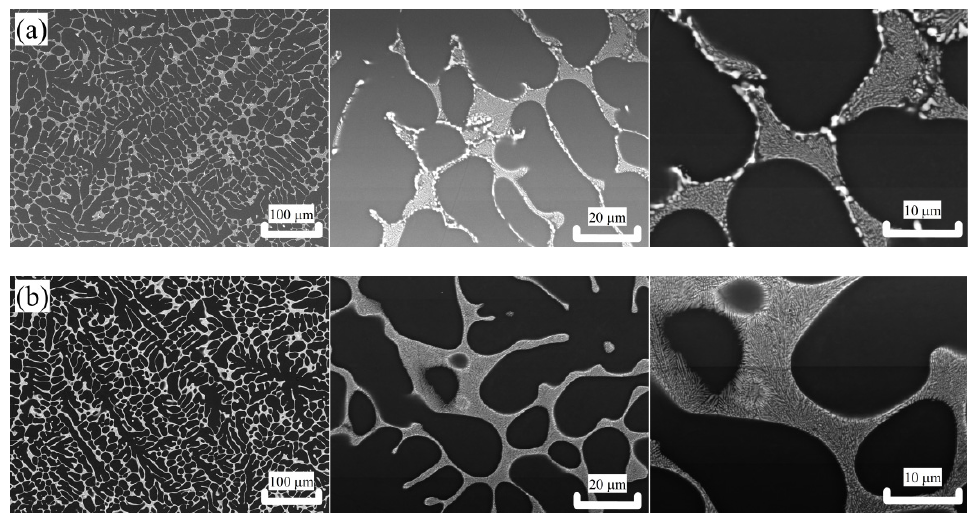
Figure 2. As cast microstructure of the Al-Cu-Yb ( a ) and Al-Cu-Gd ( b ) alloys at different magnification.